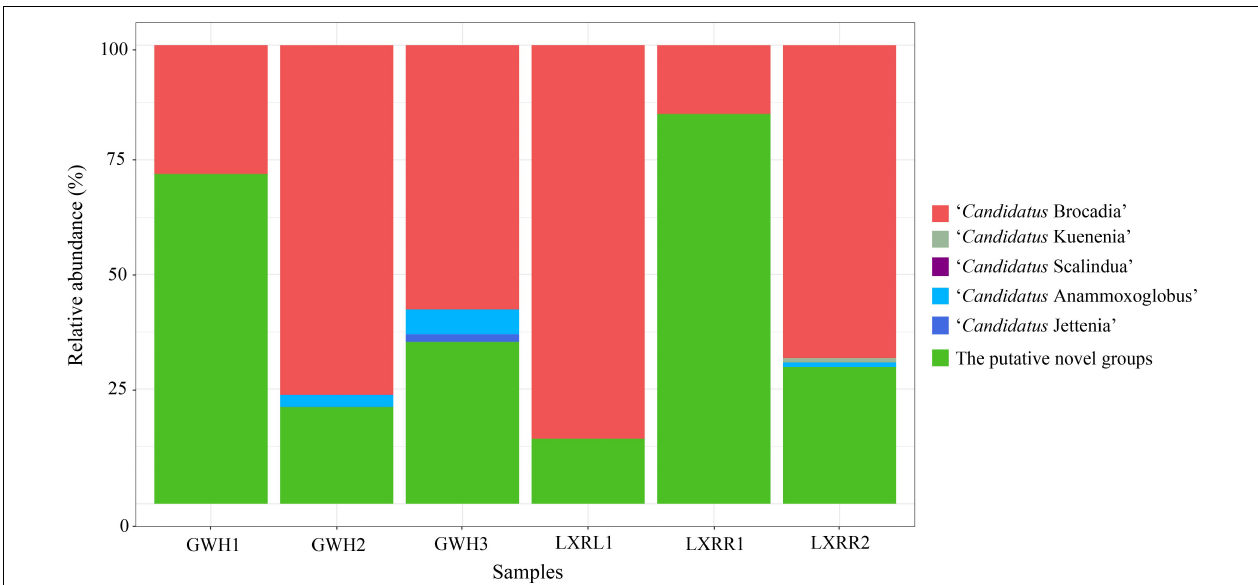
FIGURE 2 | Taxonomic classifications of anammox 16S rRNA gene sequences retrieved from the hot spring at the genus level. The colors indicate different taxa. The horizontal axis is the sample, and the vertical axis is the relative